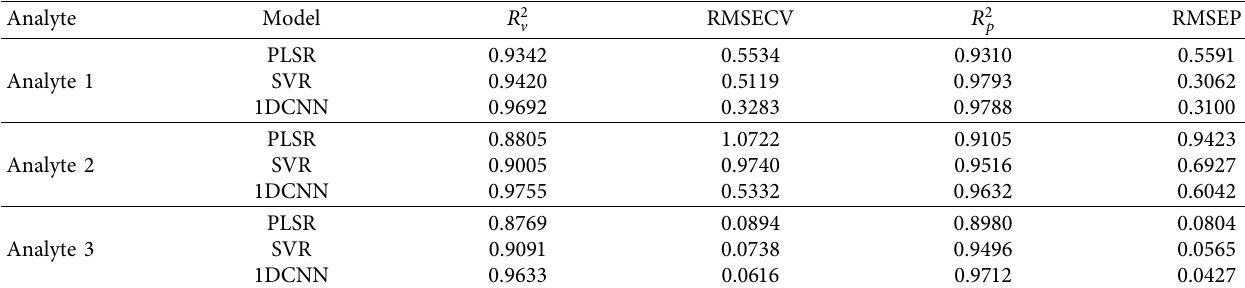
Table 3: Comparison of evaluation indices of the 1DCNN model, PLSR model, and SVR model with spectra with outliers.